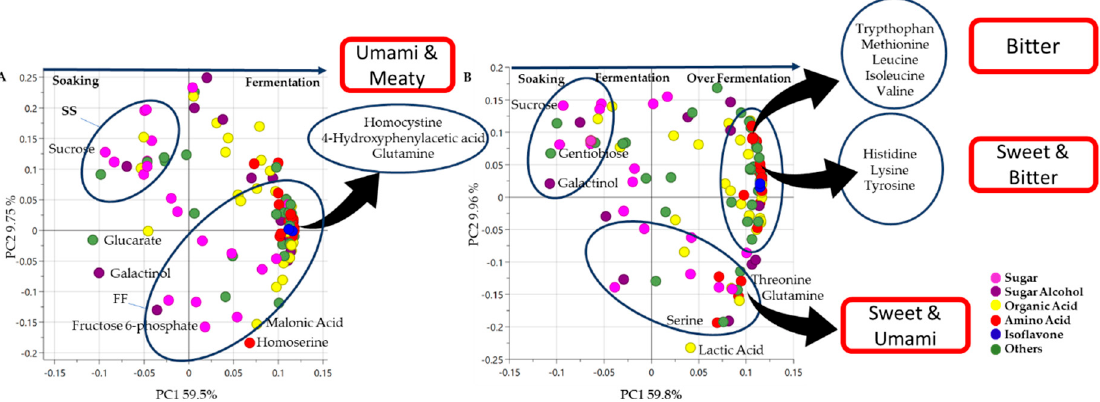
Figure 6. ( A ) Loading plot of soybeans during tempe production from soybean soaking (SS) to the 48 h fungal fermentation (FF) process. ( B ) Loading plot of soybeans from soybean soaking (SS) to 72 h over-fermented tempe (OF). The lilac color indicates sugars, the purple color indicates sugar alcohols, the yellow color indicates organic acids, the red color indicates amino acids, and the blue color indicates others. SS: soaked soybean, FF: fungal fermentation, OF: over-fermentation.